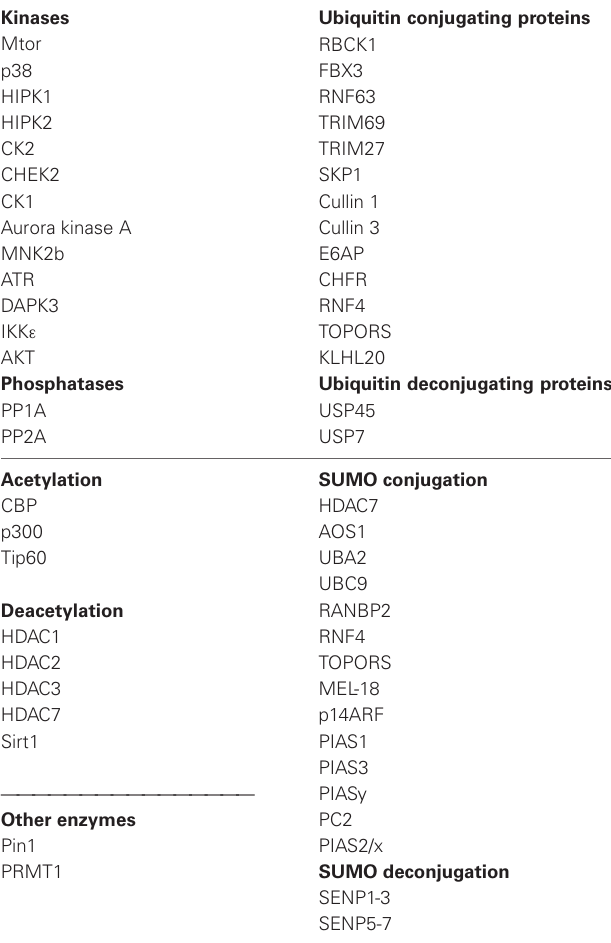
Table 1 | Post-translational modifiers in